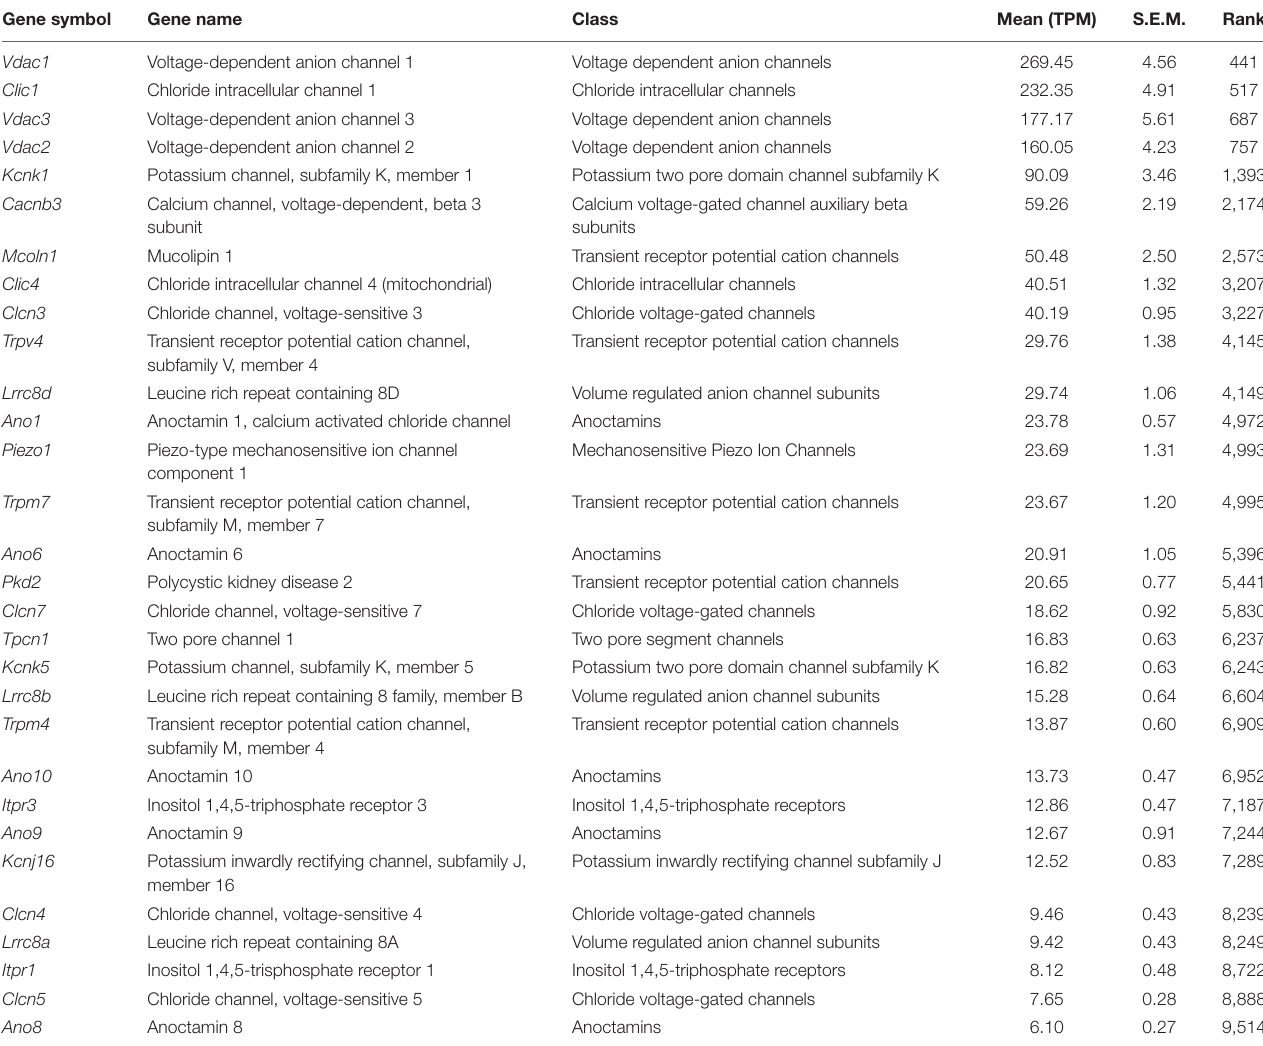
TABLE 2 | Top 30 ion channels (see the full ion channel list in Supplementary Table 1